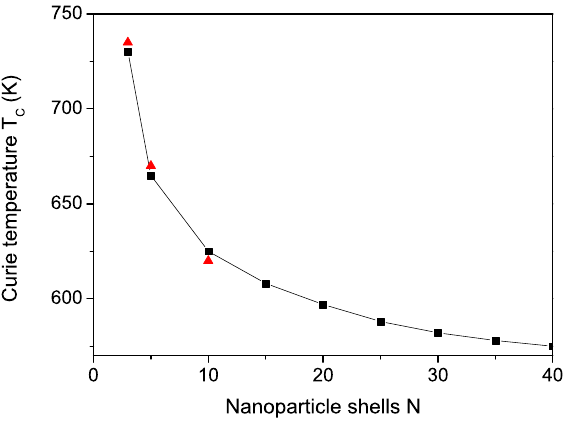
Figure 2. Size dependence of the Curie temperature T C with J s = 1.2 J b , D s = 20 D b . The red triangles are the experimental data from Ref.